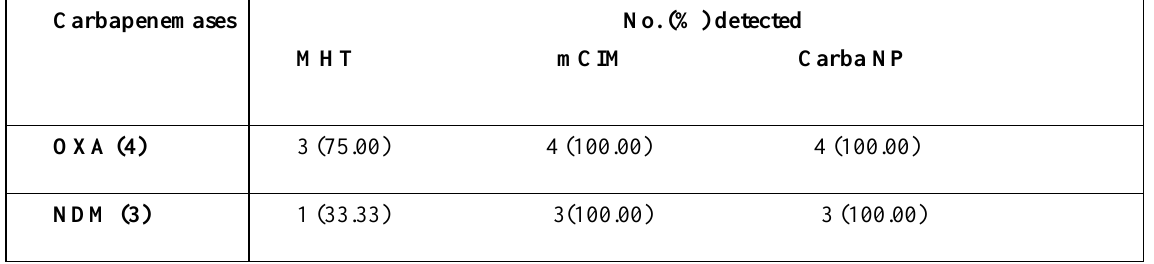
Table 2. Distribution of OXA and NDM among the isolated bacteria using different phenotypic tests. Carbapenemases